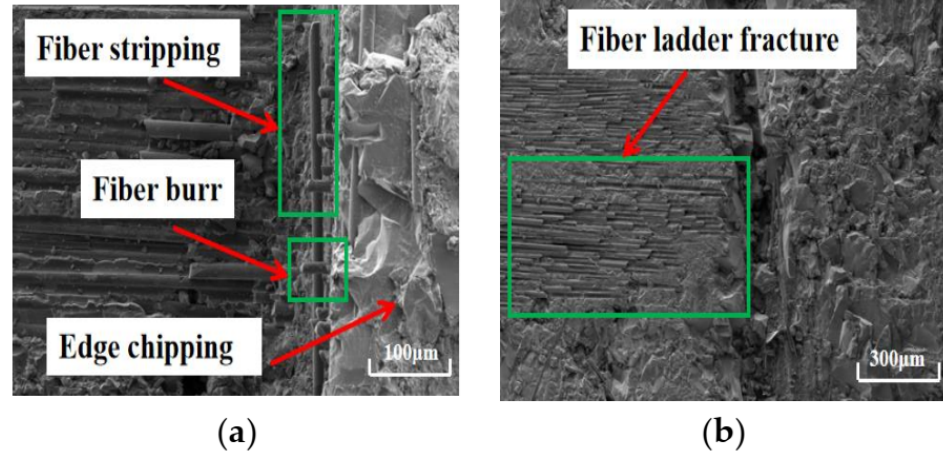
Figure 10. Morphology of the surface machined with PCD tool in dry machining: ( a ) sidewall ( × 220); ( b ) bottom ( × 70).